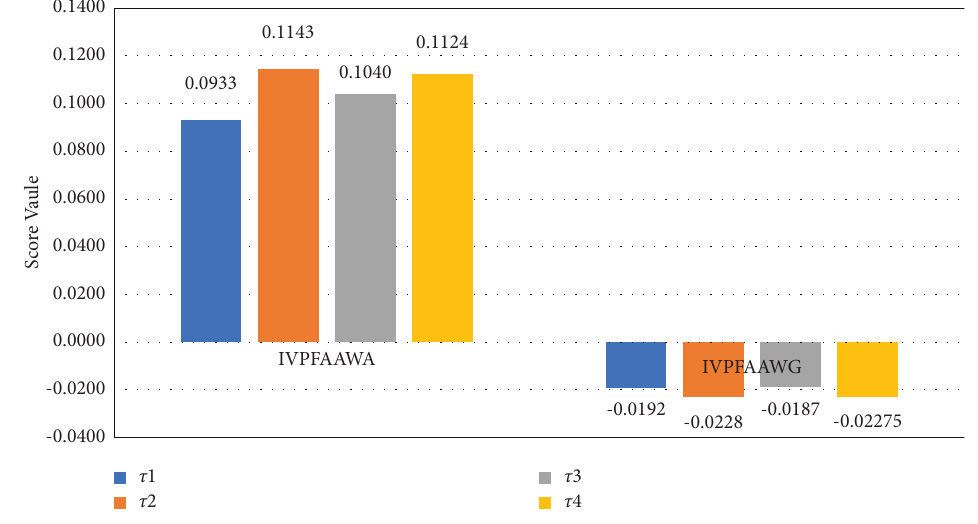
Figure 1: Representation of IVPFAAWA and IVPFAAWG operators for ᵿ � 1.